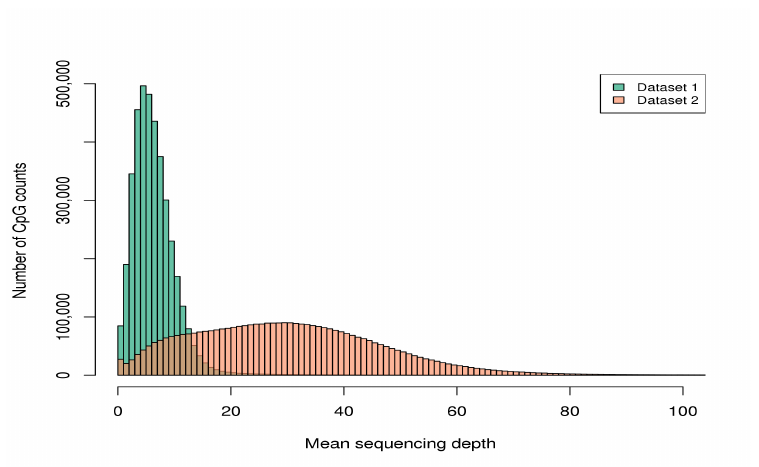
Figure 1. Histograms of mean sequencing depth across the CpGs covered by both datasets in the targeted